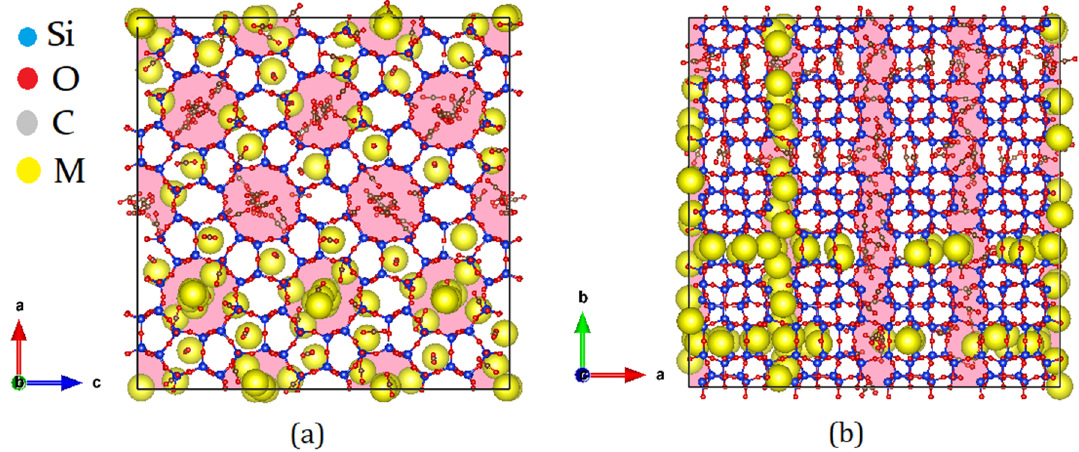
Figure 1. Simulation snapshots of CO 2 adsorption in the system S2Z2 at 100 atm in the crystallographic planes a–c ( a ) and a–b ( b ). The straight channels in the silicalite samples are highlighted in pink. Half of the straight and zigzag channels are blocked by stuffing them with methane molecules, which are shown as yellow spheres. Table 1. Different systems simulated and the corresponding number of pore connections. S4Z4 is the unmodified silicalite. Systems with a larger number of straight channels that are free, compared to free zigzag channels, are highlighted with red-colored text (S-majority), while those with a larger number of free zigzag channels, compared to free straight channels, are highlighted in blue-colored text (Z-majority). Systems where half of the free space available in the unmodified silicalite is blocked/free are highlighted with yellow background and the system S2Z2 with half each of the straight and zigzag channels blocked/free is shown in green text